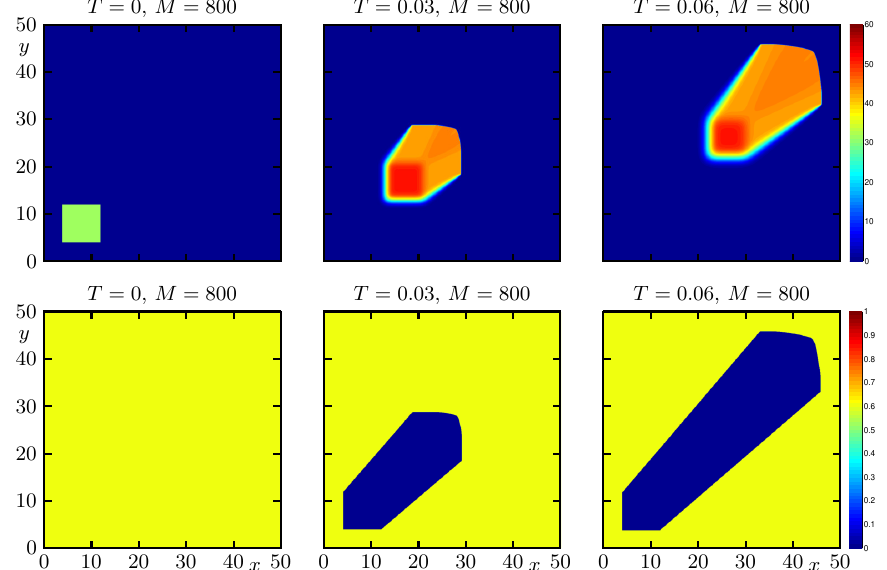
Figure 2. Example 1: Evolution of the dynamics of temperature ( top ) and fuel ( bottom ). Numerical approximation with LIMEX for ∆ x = ∆ y =